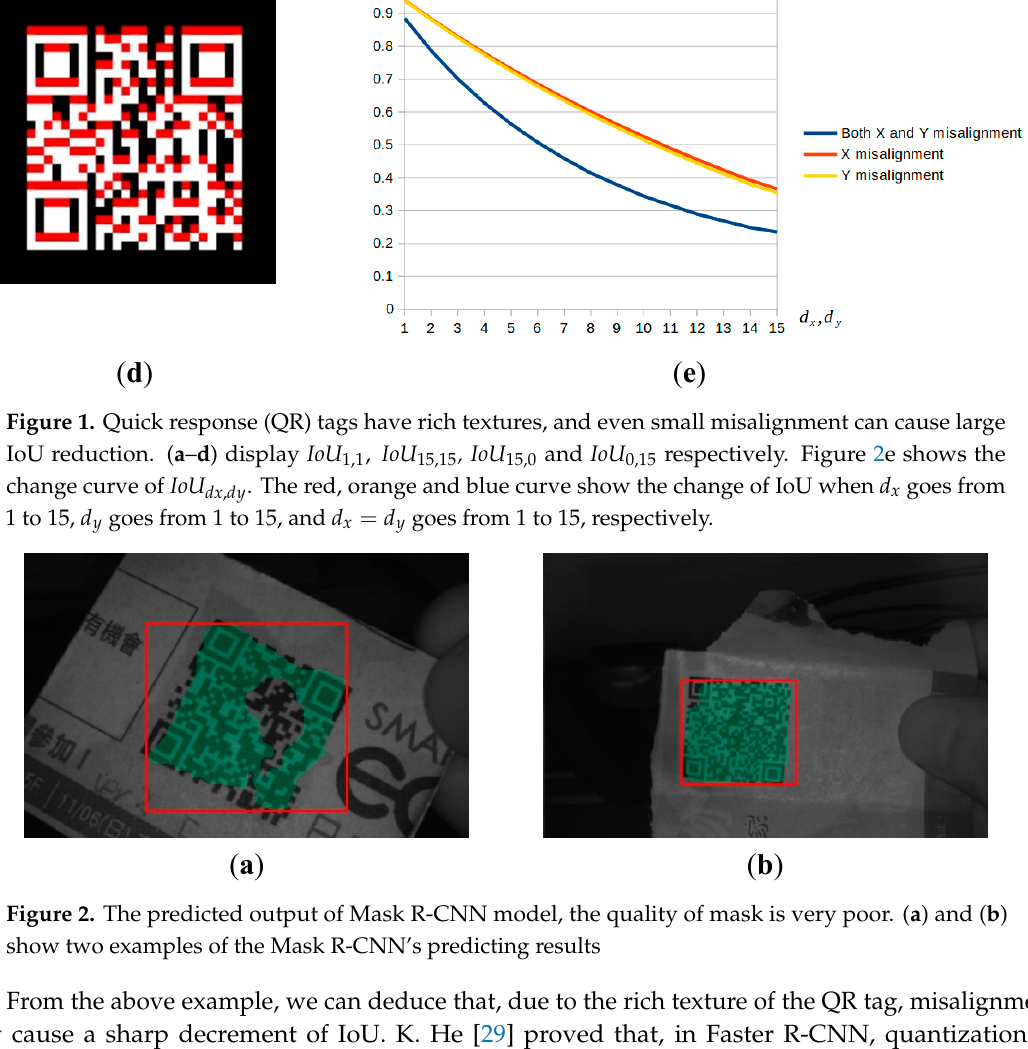
Figure 1. Quick response (QR) tags have rich textures, and even small misalignment can cause large IoU reduction. ( a – d ) display 𝐼𝑜𝑈 (cid:2869),(cid:2869) , 𝐼𝑜𝑈 (cid:2869)(cid:2873),(cid:2869)(cid:2873) , 𝐼𝑜𝑈 (cid:2869)(cid:2873),(cid:2868) and 𝐼𝑜𝑈 (cid:2868),(cid:2869)(cid:2873) respectively. Figure 2 e shows the change curve of 𝐼𝑜𝑈 (cid:3031)(cid:3051),(cid:3031)(cid:3052) . The red, orange and blue curve show the change of IoU when 𝑑 (cid:3051) goes from 1 to 15, 𝑑 (cid:3052) goes from 1 to 15, and 𝑑 (cid:3051) = 𝑑 (cid:3052) goes from 1 to 15, respectively